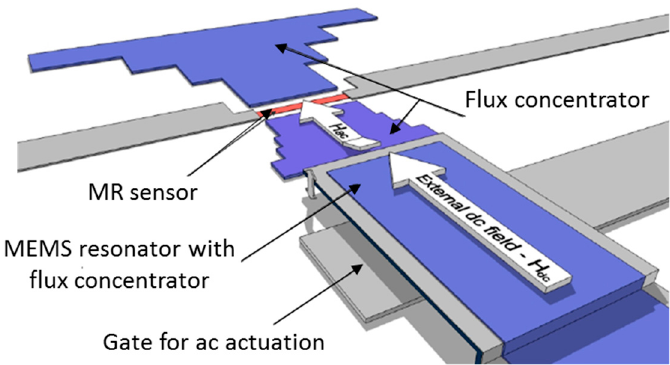
Figure 3. Schematic of a MR-MEMS hybrid device used for high frequency modulation of (quasi-)DC magnetic fields, where a MEMS cantilever with incorporated MFCs oscillates at high frequency to modulate the signal of interest. (Courtesy of A. Guedes).